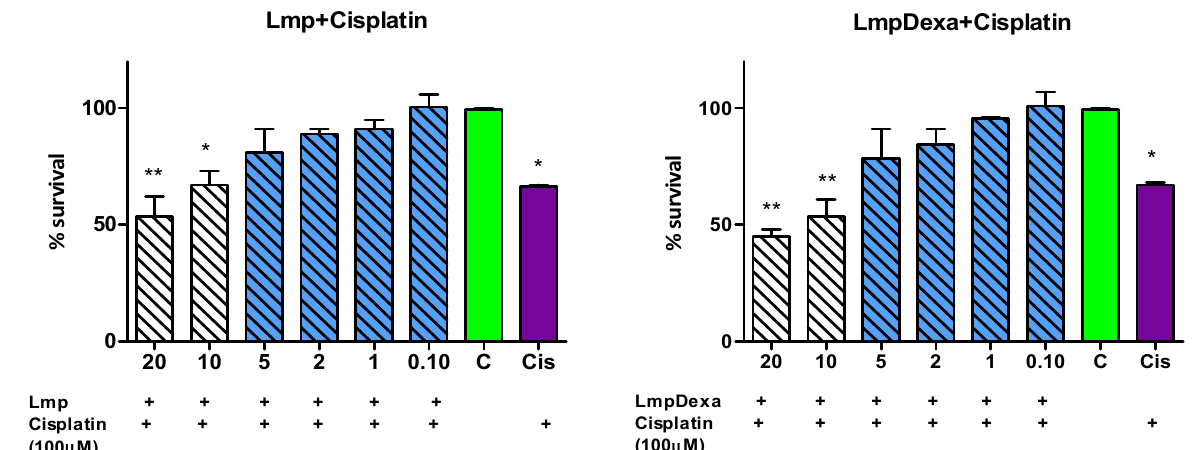
Figure 9. Lmp and Lmp/Dexa effect on cisplatin treated HEI-OC1 cells. (One-way ANOVA, Dunnett post-test). (** p < 0.01; * p < 0.5).